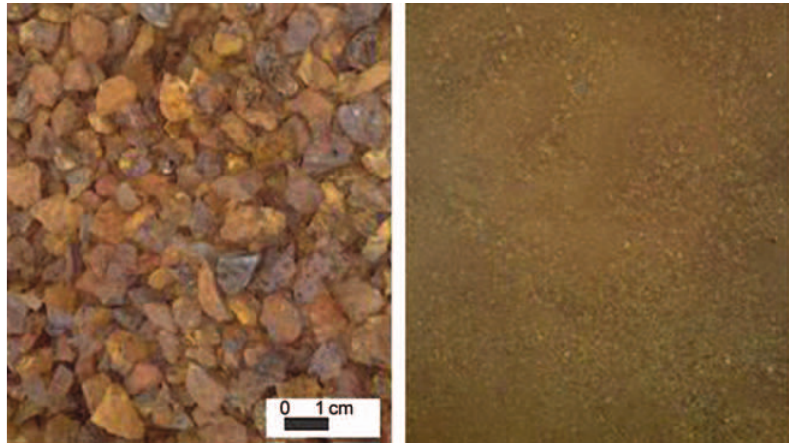
Figure 2 Coarse (left) and fi ne (right) hematite aggregates.